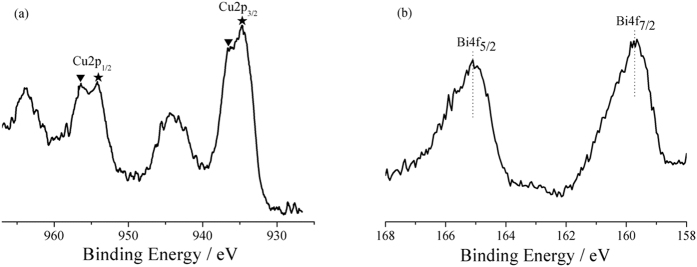
XPS spectra of (a) Cu 2p, (b) Bi 4f on the Cu1Bi1-mBeta catalyst.